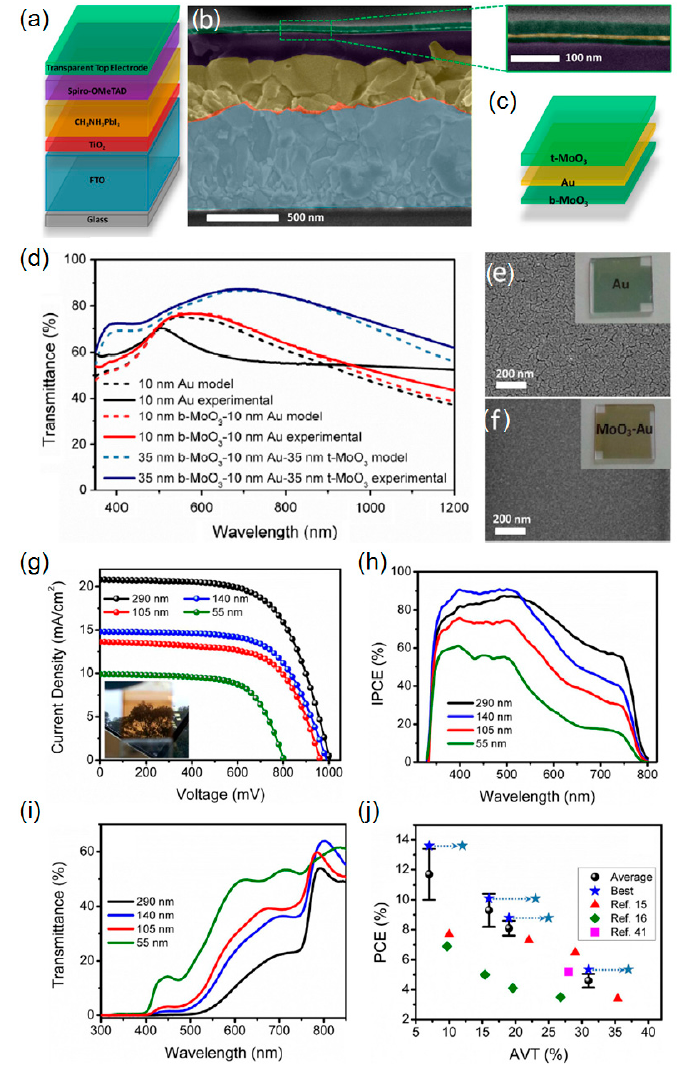
Figure 2. ( a ) Schematic illustration (not to scale) of the semitransparent perovskite solar cell architecture employing a dielectric-metal-dielectric (DMD) multilayer electrode atop. ( b ) SEM image in cross section of a complete device. ( c ) Enlarged view of the multilayer top electrode and schematic of its structure. ( d ) Simulations (shaded dashed lines) and experimental data (solid lines) showing the transmittance of Au (black), b-MoO 3 /Au (red) and b-MoO 3 /Au/t-MoO 3 (blue). ( e ) SEM image of Au film. ( f ) SEM image of b-MoO 3 /Au film. The insets show photos of the two samples. ( g ) J - V curves of the semitransparent perovskite solar cells under air mass (AM) 1.5 (1 sun) illumination. All devices were illuminated from the fluorine-doped tin oxide (FTO) side. The inset shows a photograph of the fabricated device. ( h ) Incident photon-to-current efficiency (IPCE) spectra and ( i ) transmittance spectra of complete perovskite solar cells with different CH 3 NH 3 PbI 3 film thicknesses. ( j ) Plot of the PCE (average and best) as a function of AVT (370–740 nm) and comparison with other semitransparent perovskite solar cells. The arrows show the performance of our best devices if the AVT is calculated between 400 and 800 nm, for a fair comparison with previously published results. Reproduced with permission [14]. Copyright 2015,